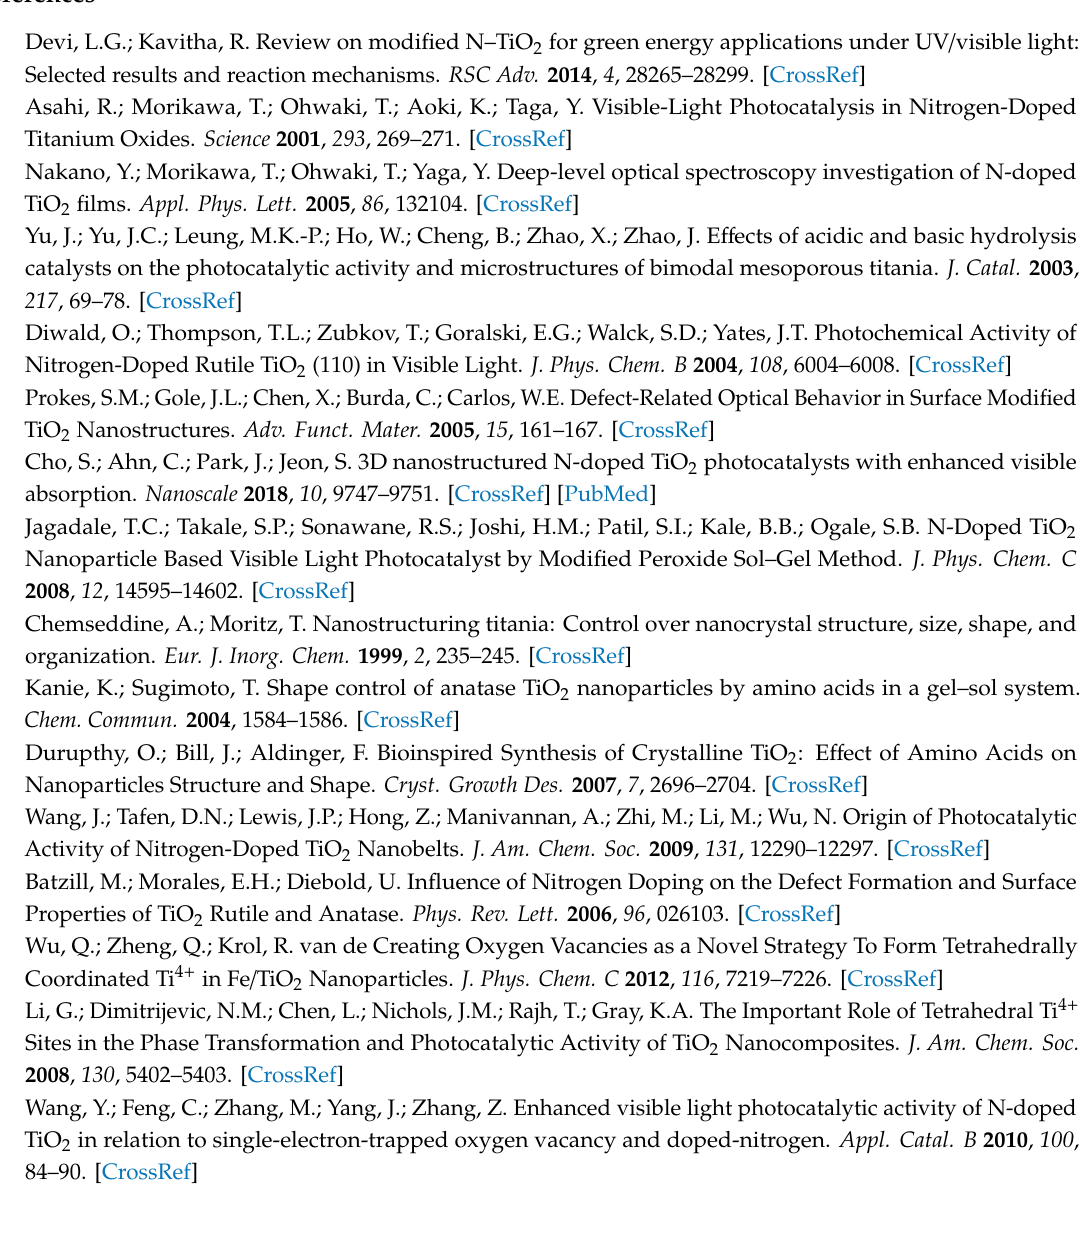
Figure S1: Size distributions of MTiO 2 / Ala-DDA, Figure S2: A comparison of photocatalytic degradation of phenol under visible light (The initial concentration of phenol was 5 ppm (50 mL) and the amount of the photocatalyst used was 25